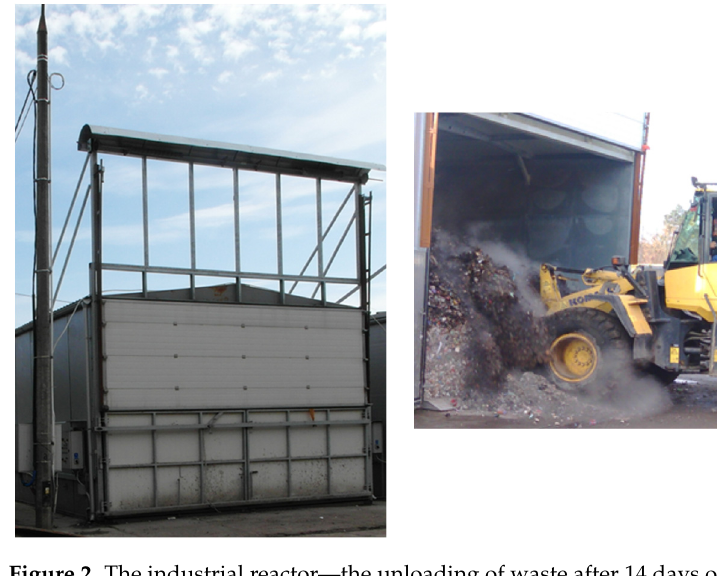
Figure 2. The industrial reactor—the unloading of waste after 14 days of biodrying.